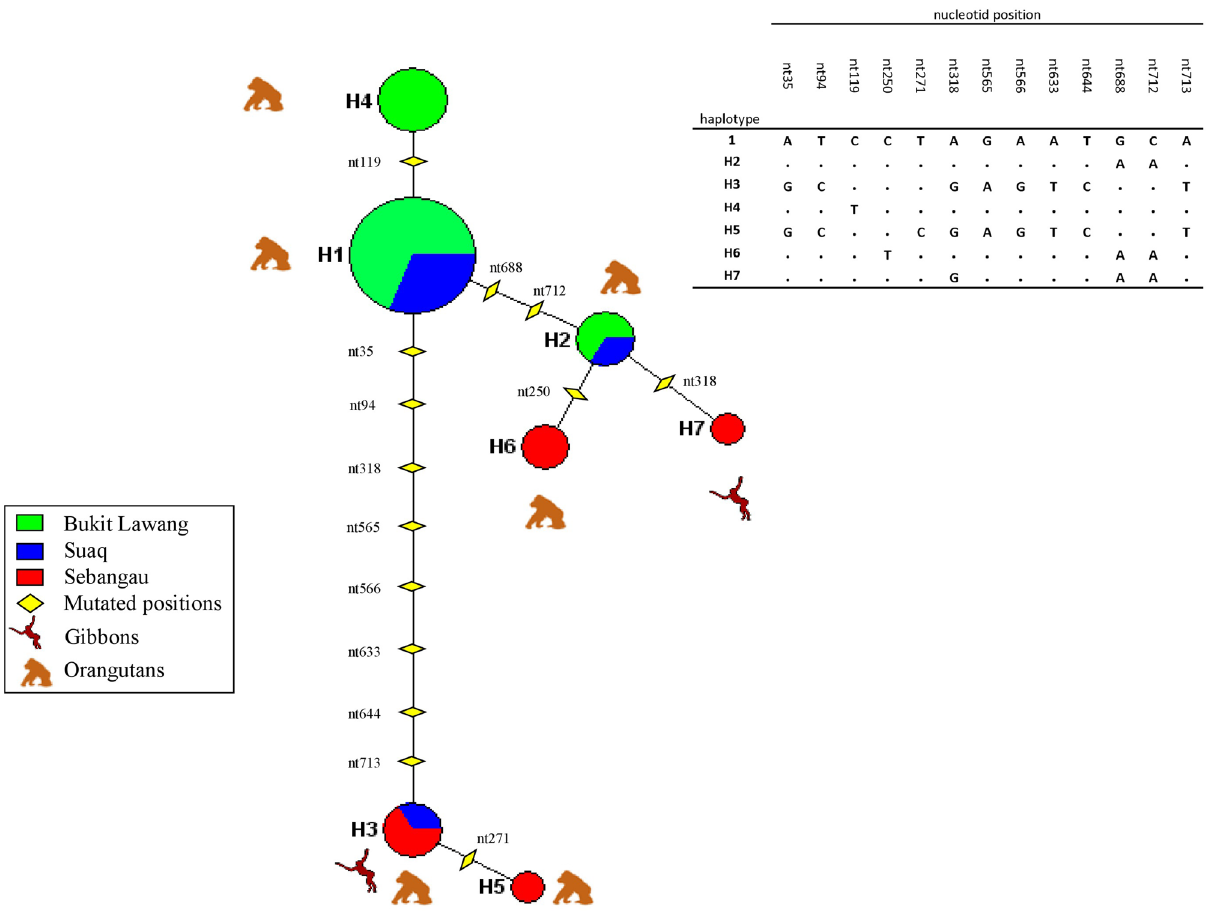
Figure 2. ( a ) Haplotype networks constructed using NETWORK 5.0.0.0. The network was built using a 758-bp-long fragment containing the ITS1-5.8S-ITS2 rDNA from 27 O. aculeatum specimen from this work. Node sizes (circles) are proportional to haplotype frequencies. Node colors indicate geographic origin. ( b ) Detected mutation positions on the 758-bp-long fragment containing the ITS1-5.8S-ITS2